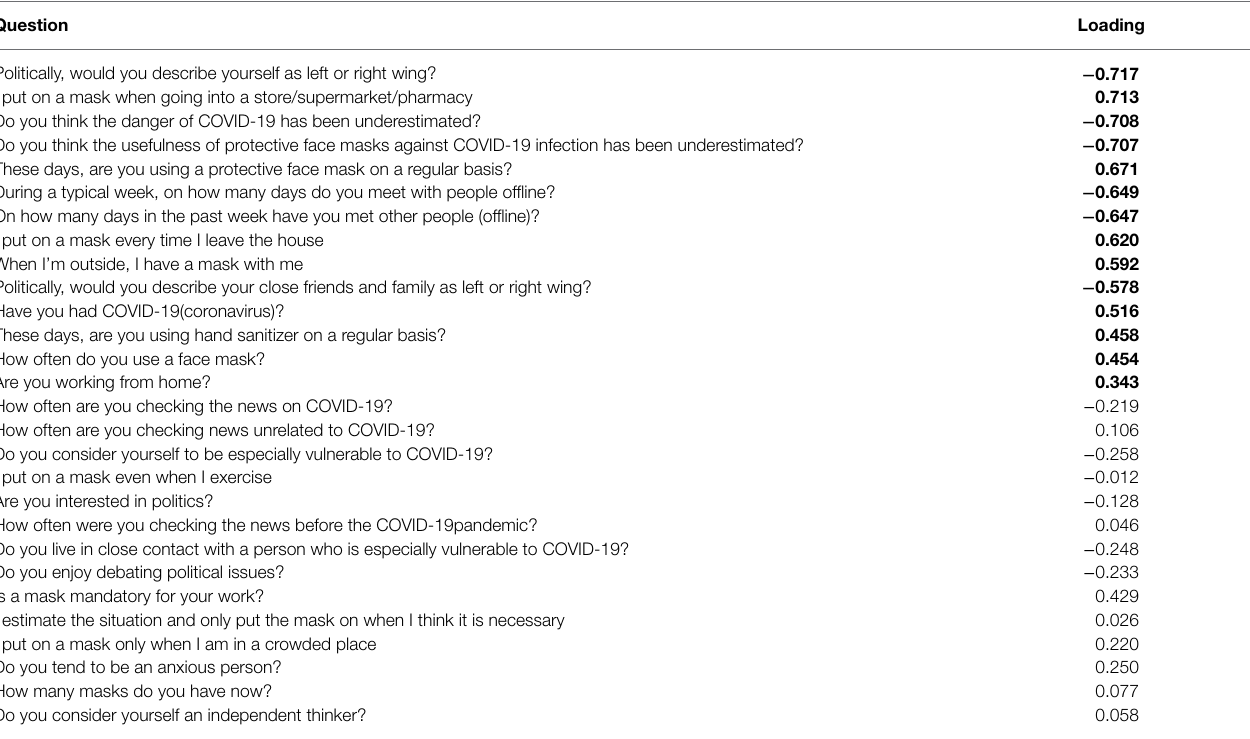
TABLE 1 | Twenty-eight questions for PCA and their loading on the first component. Question